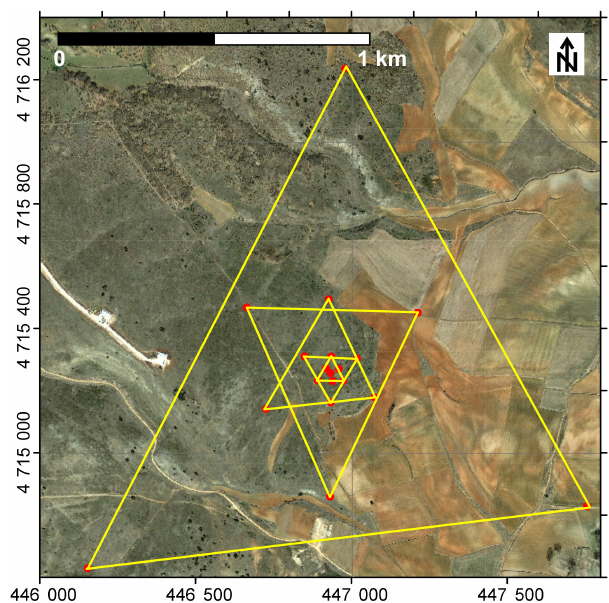
Figure 2. Geometry used for the seismic noise measurements at array 1. Red circles mark the position of the stations and yellow lines show the triangle setup. Map is shown in UTM coordinates inm, ETRS89